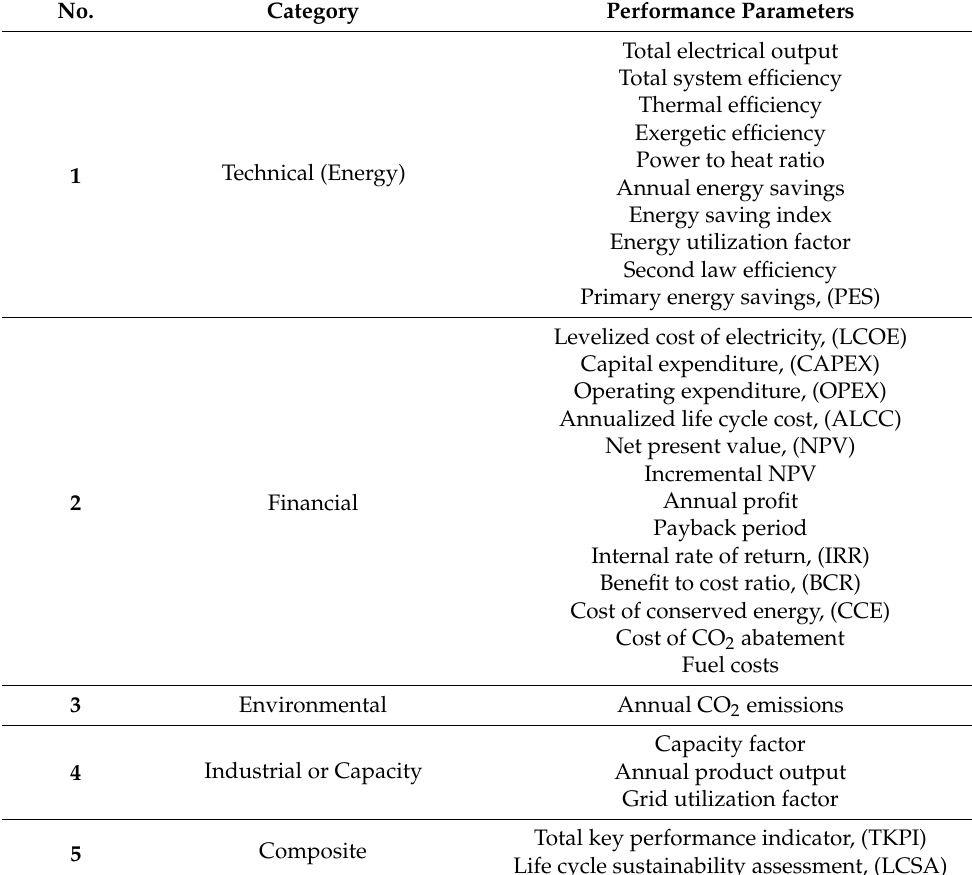
Table 3. Performance categories and parameters.